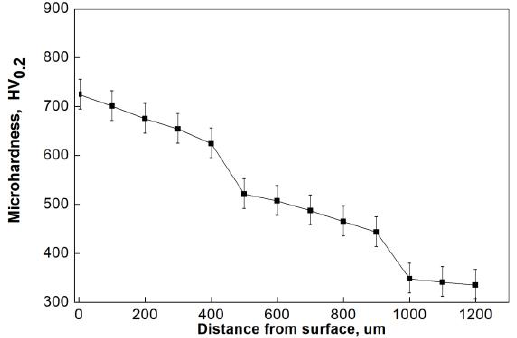
Figure 9. Microhardness distribution of cladding cross-section.